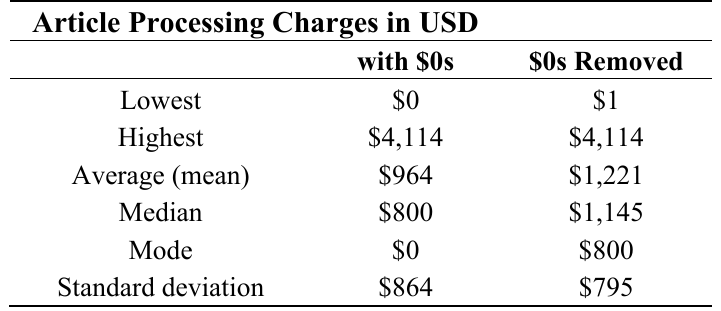
Table 4. Article processing charges in USD: range and measures of